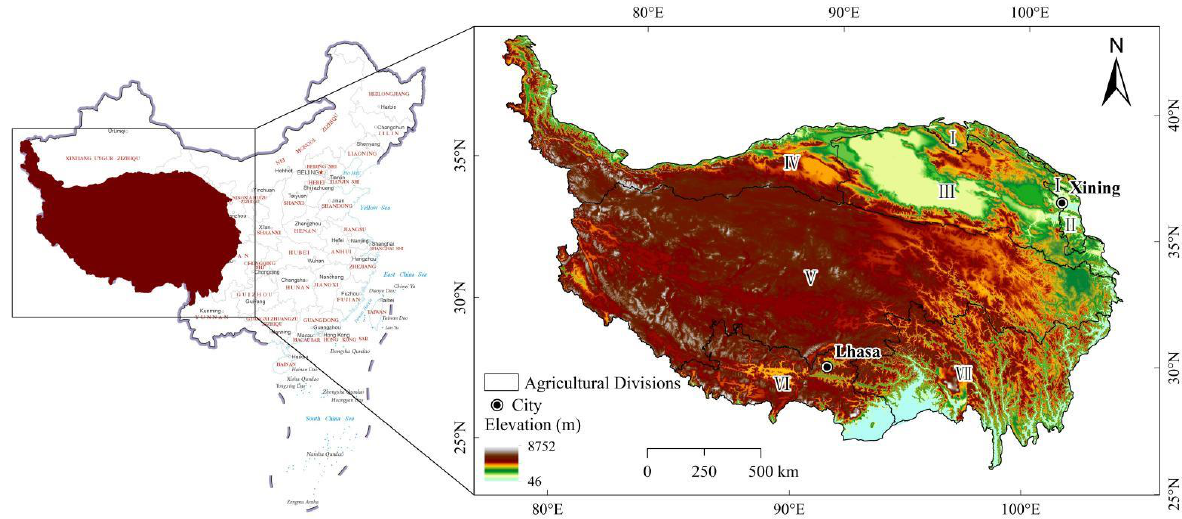
Figure 1. Agricultural divisions on the Qinghai–Tibet Plateau.